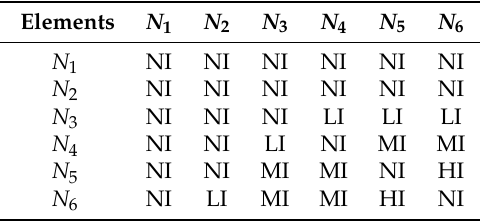
Table 2. Linguistic evaluations of input.